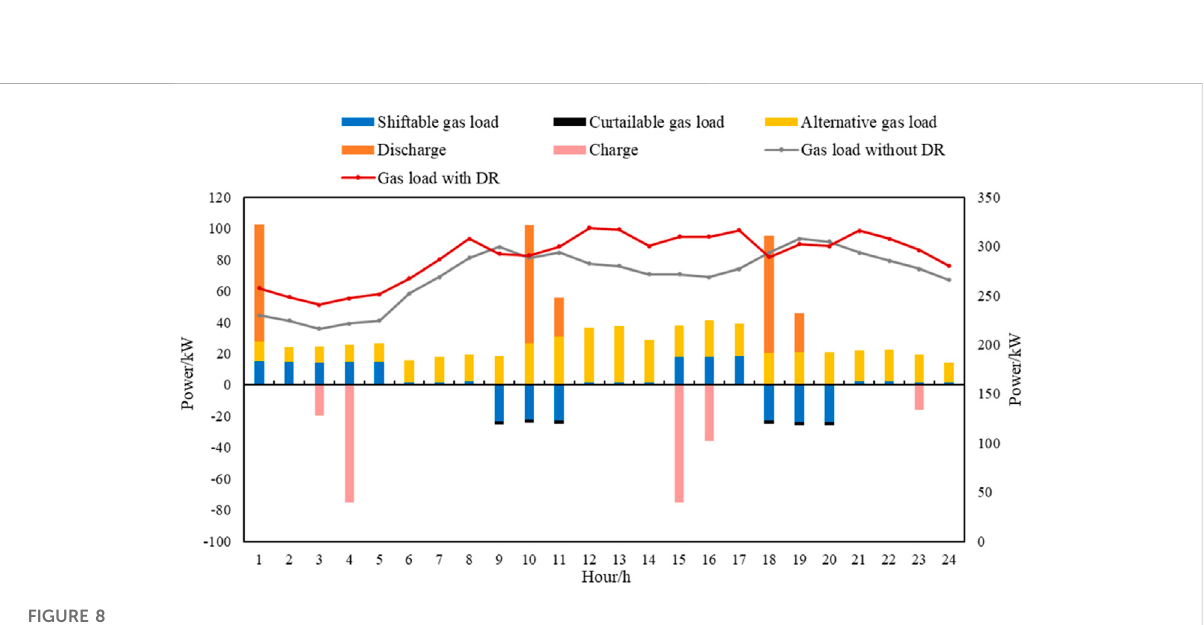
FIGURE 7 Scenario 6 Changes in the electrical load of the IES.